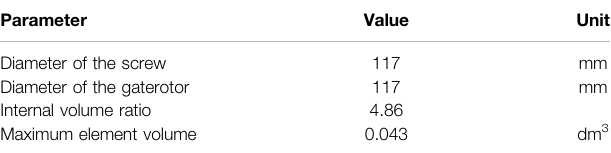
TABLE 1 | Parameters of the SSE prototype.